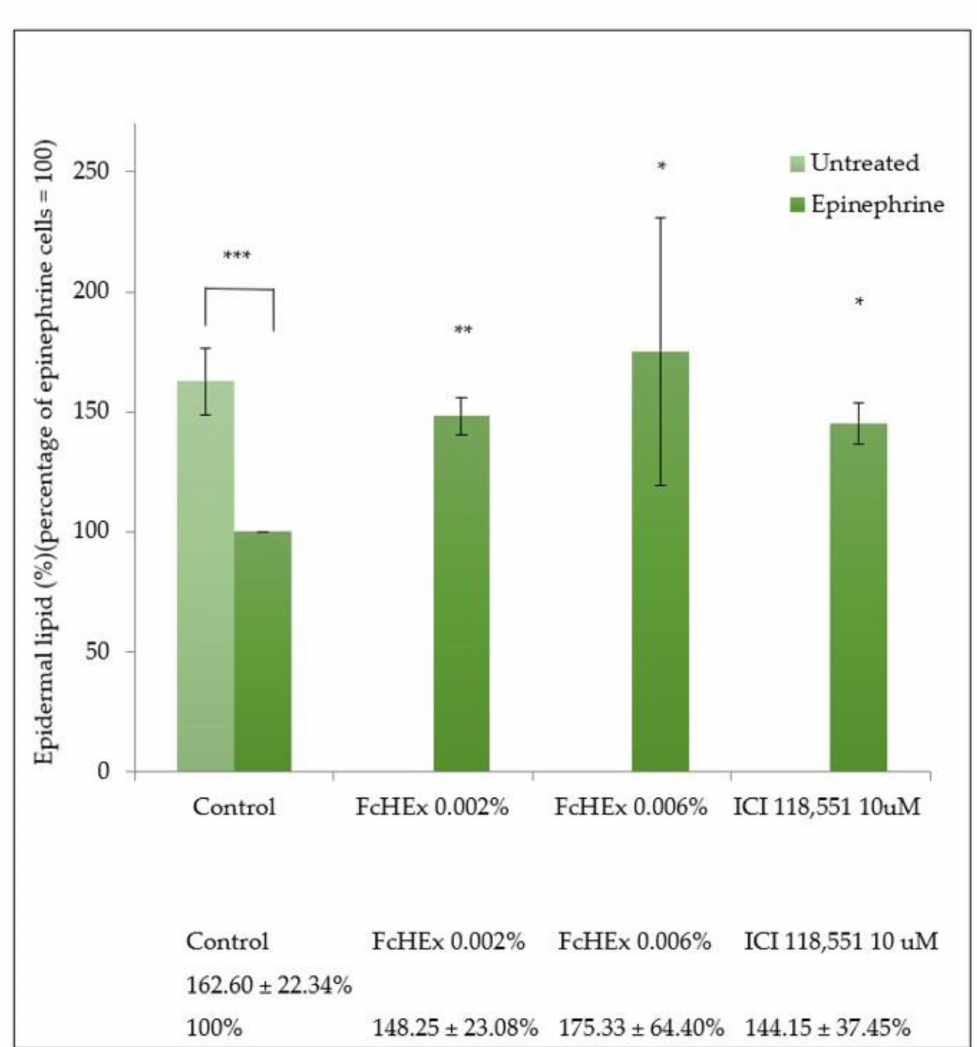
Figure 8. Effect of the FcHEx on the epidermal lipid content in the skin keratinocytes. The HaCaT cells were treated with the FcHEx or the positive control for 24 h, then incubated with epinephrine 10 µ M for an additional 24 h. The lipid content was measured using an Adipored assay. The values were normalized relative to the cell density determined using crystal violet staining. The reported values represent the averages of three independent experiments and are expressed as the percentages of cells treated with epinephrine only, which was set to 100%. The asterisks indicate statistically significant values (*** p -value was between 0.0001 and 0.001; ** p -value was between 0.001 and 0.01; * p -value was between 0.01 and